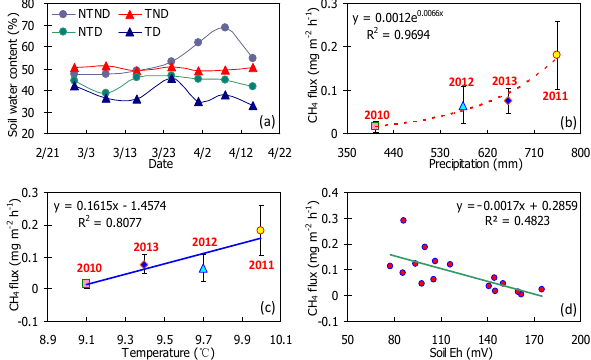
Figure 3. Soil water content in the 2010 winter fallow season (a) and the relationships between mean CH 4 emission and total winter precipitation (b) , and mean daily air temperature (c) and soil Eh (d) over the four winter fallow seasons (data from Table 4).